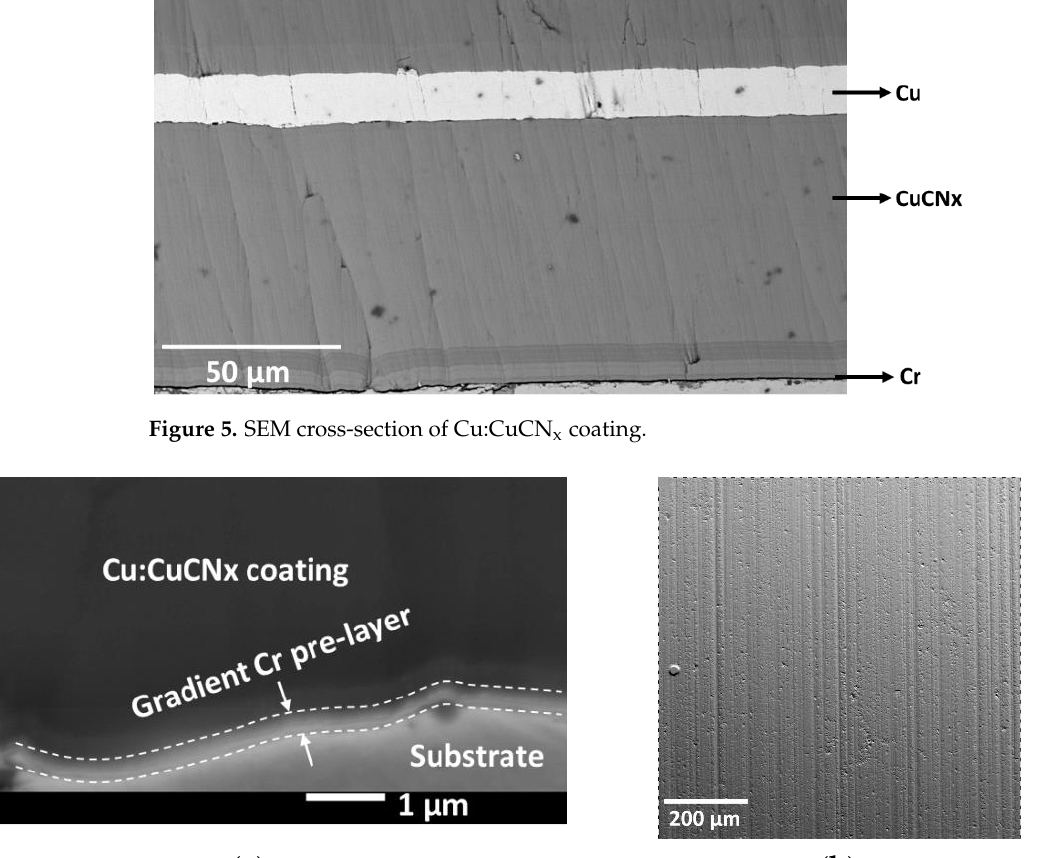
Figure 6. ( a ) SEM cross-section of Cu:CuCN x coating, Cr pre-layer. ( b ) Surface topography of HiPIMS Cr + ion-etched M shim.